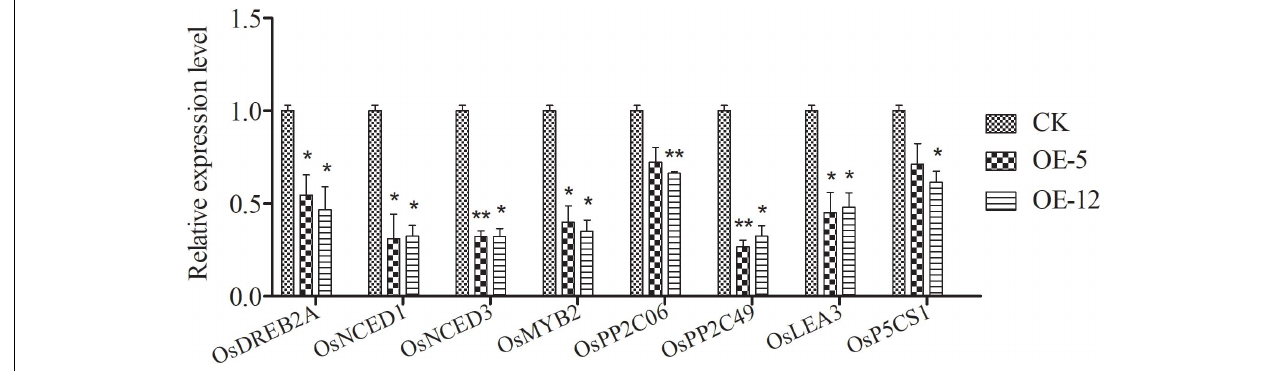
FIGURE 10 | Expression of several stress-related genes in SiMADS51 -overexpressing plants (OE-5 and OE-12) and control line (CK) under normal condition. The expression of each gene was normalized using the actin gene ( LOC_Os03g50885 ) as control. Data are presented as the means ± SDs of three independent replicates. Asterisks indicate statistical significance (* P < 0.05; and ** P < 0.01; Student’s t -test) compared with the corresponding